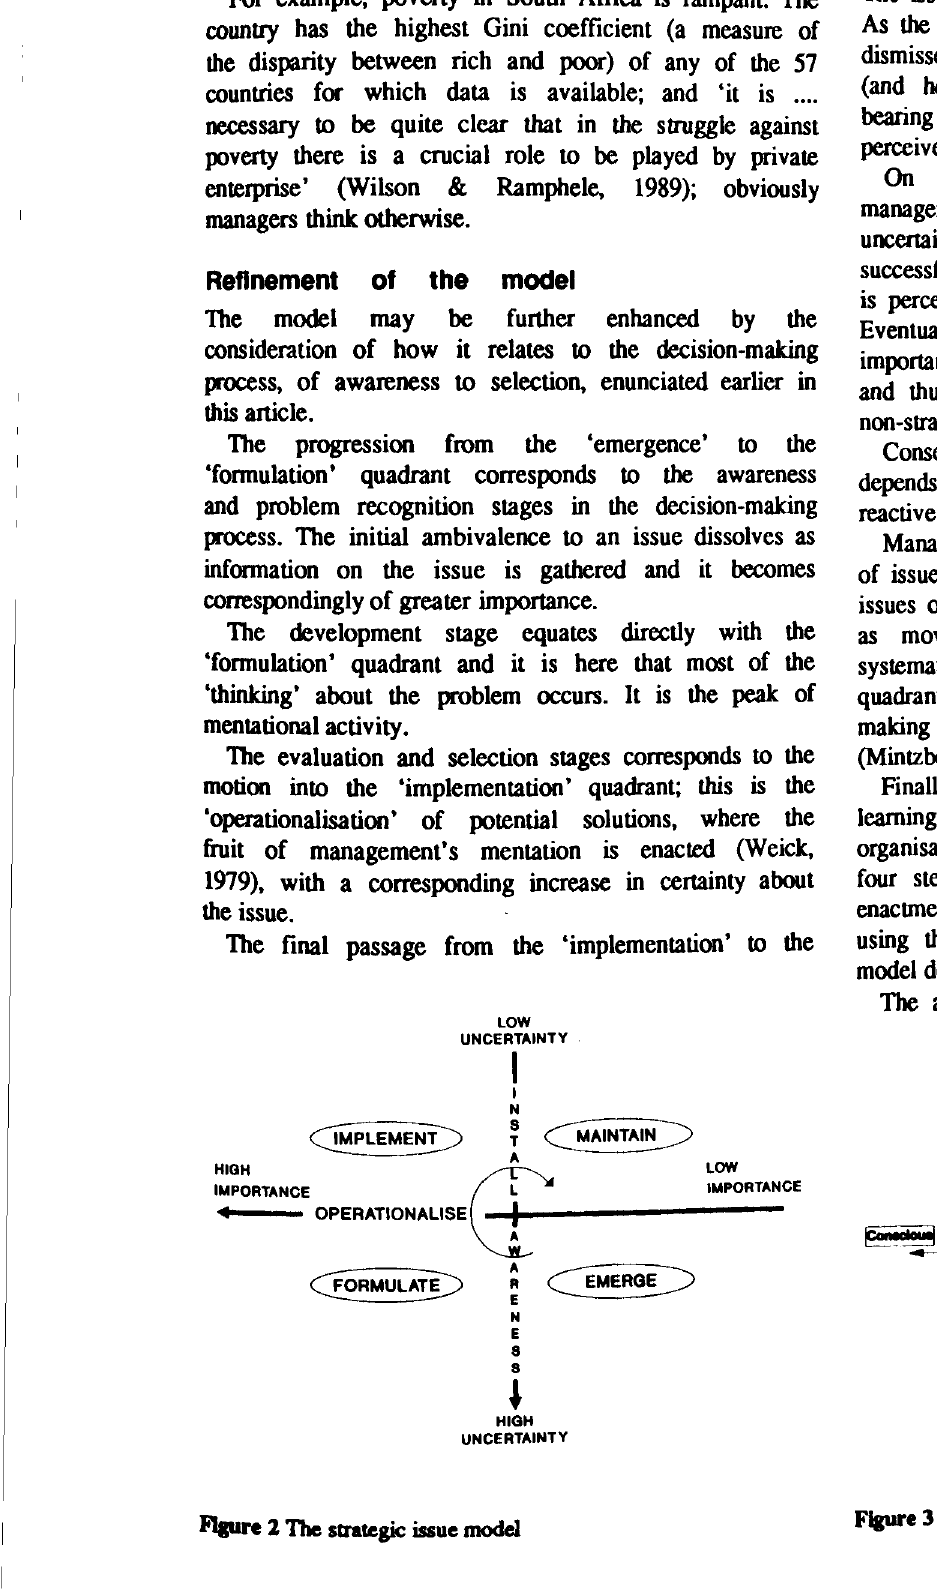
Figure 3 The strategic learning